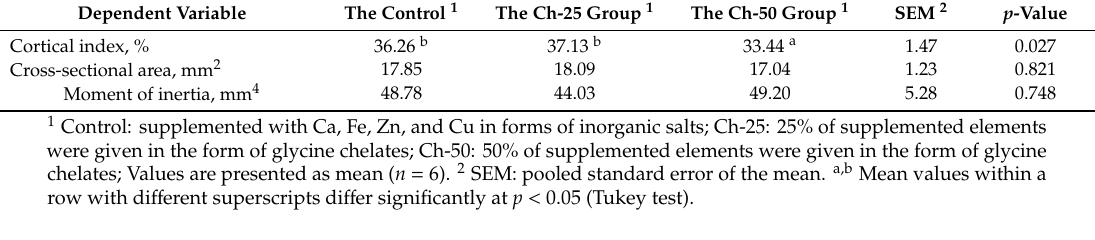
Table 4. Mechanical characteristics of tibia of 16-week-old male pheasants.